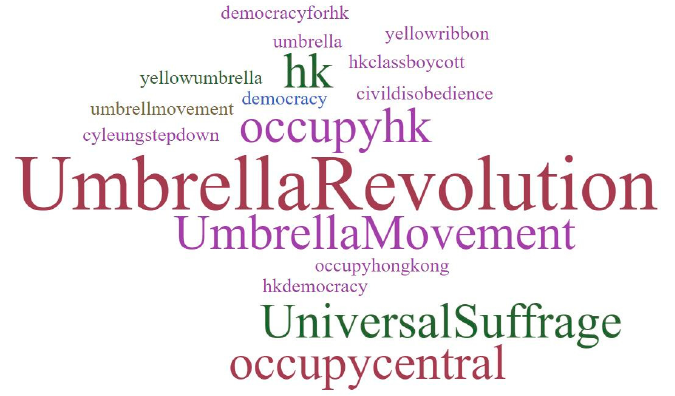
Figure 4. Word cloud for representative hashtags of the ‘Umbrella Movement’ community.